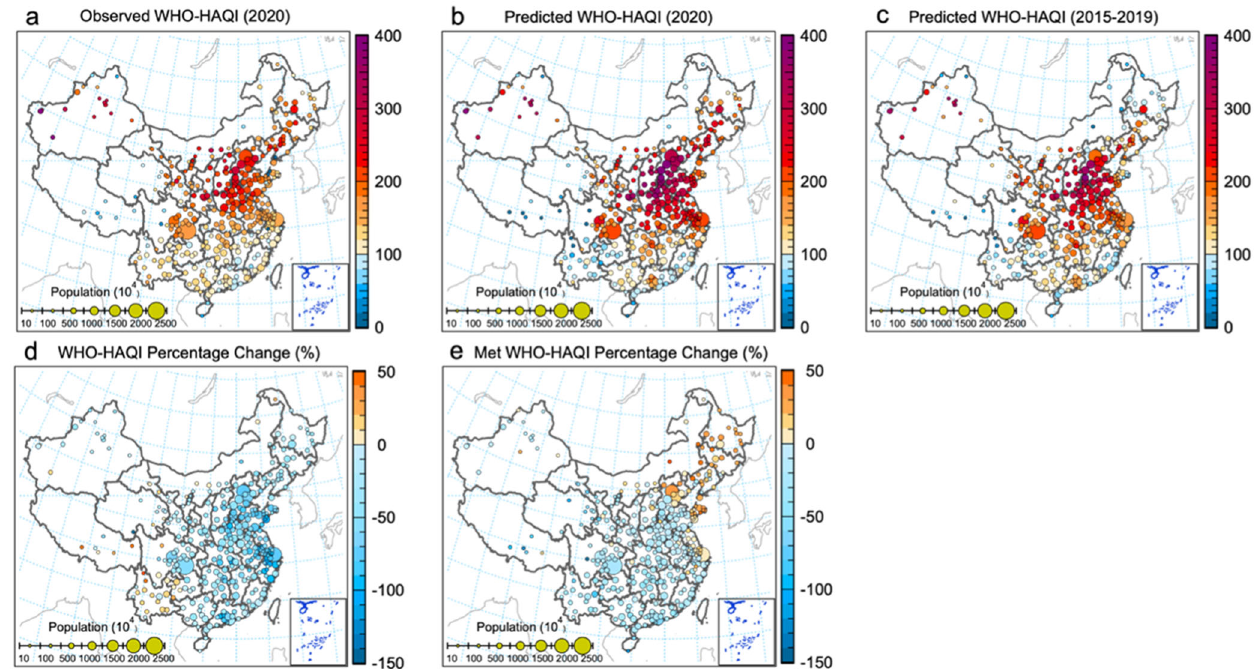
Fig. 5 Spatial distributions of WHO-HAQI and attributed changes across China. a – c show the WHO-HAQI distributions as derived from observations in 2020, from a counterfactual prediction in 2020, and the predictions averaged over 2015 – 2019, respectively. c , d show the differences between observation and prediction in 2020, and the changes attributable to meteorology (Met), respectively. Solid circles in hot color represent cities with increased percentages, and in cold color cities with decreased percentages. The size of the circles represents each city ’ s population.